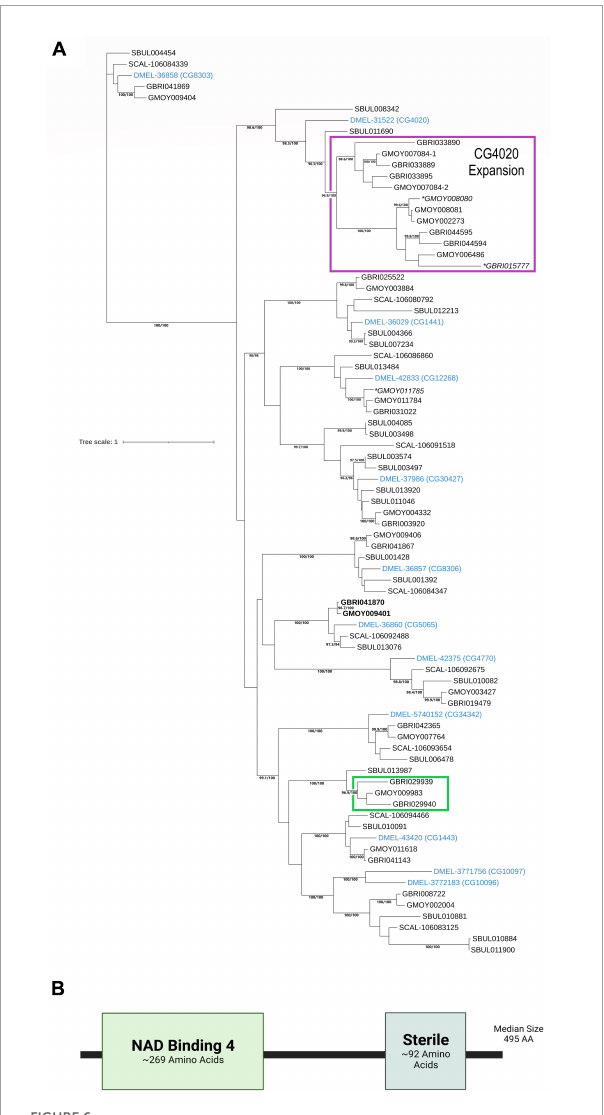
FIGURE6 Phylogenetic and structural analyses of Glossina fatty acyl-CoA reductases. (A) A maximum likelihood tree for Glossina amino acid sequences identified as having fatty acyl-CoA activity by VectorBase in Glossina morsitans ( n = 17) or Glossina brevipalpis ( n = 18), genes identified as syntenic in D. melanogaster and S. calcitrans,